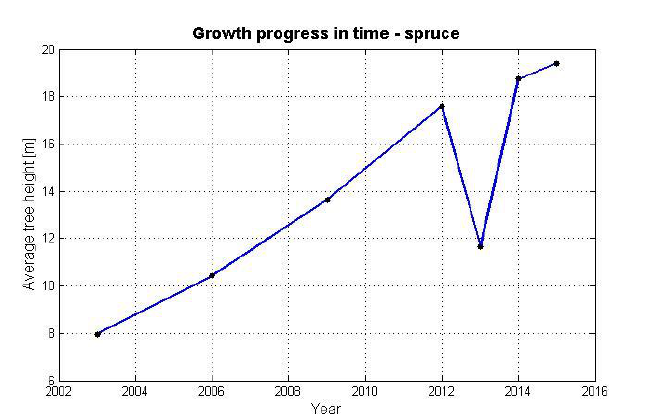
Figure 3. The DSM average height values generated from LIDAR data in